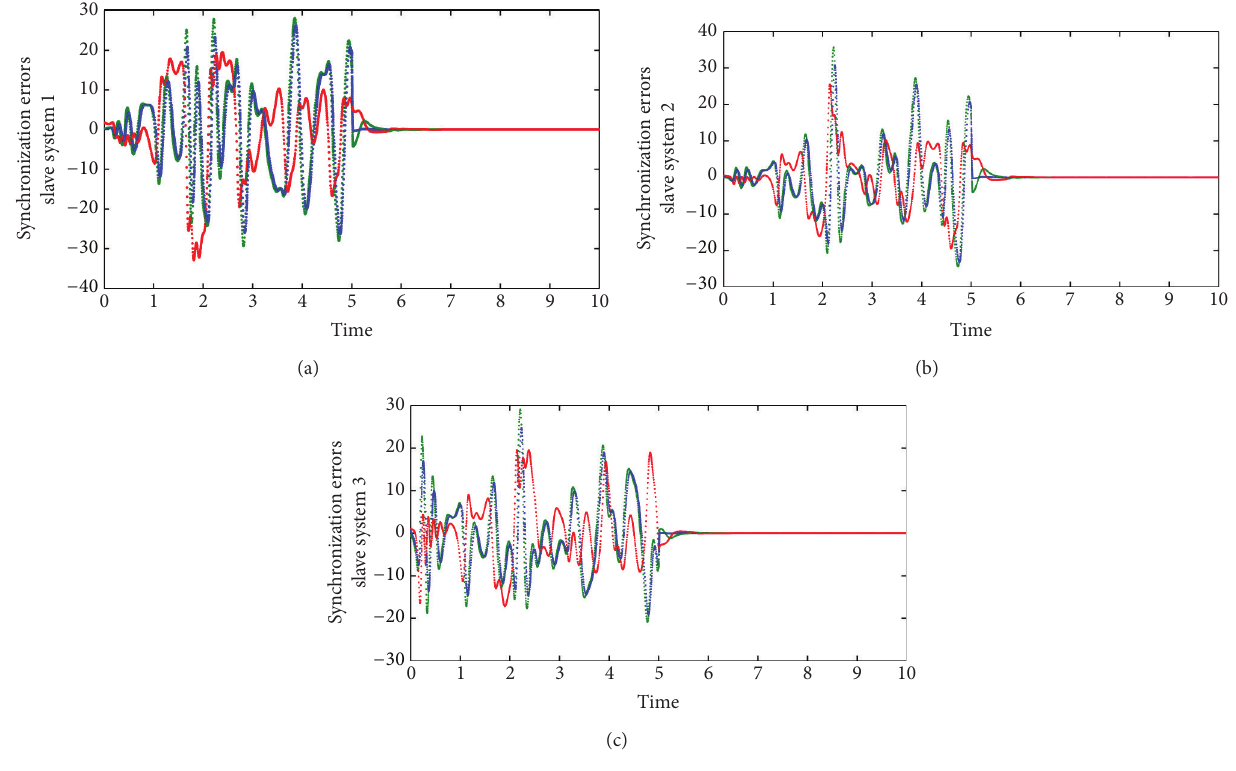
Figure 3: Synchronization